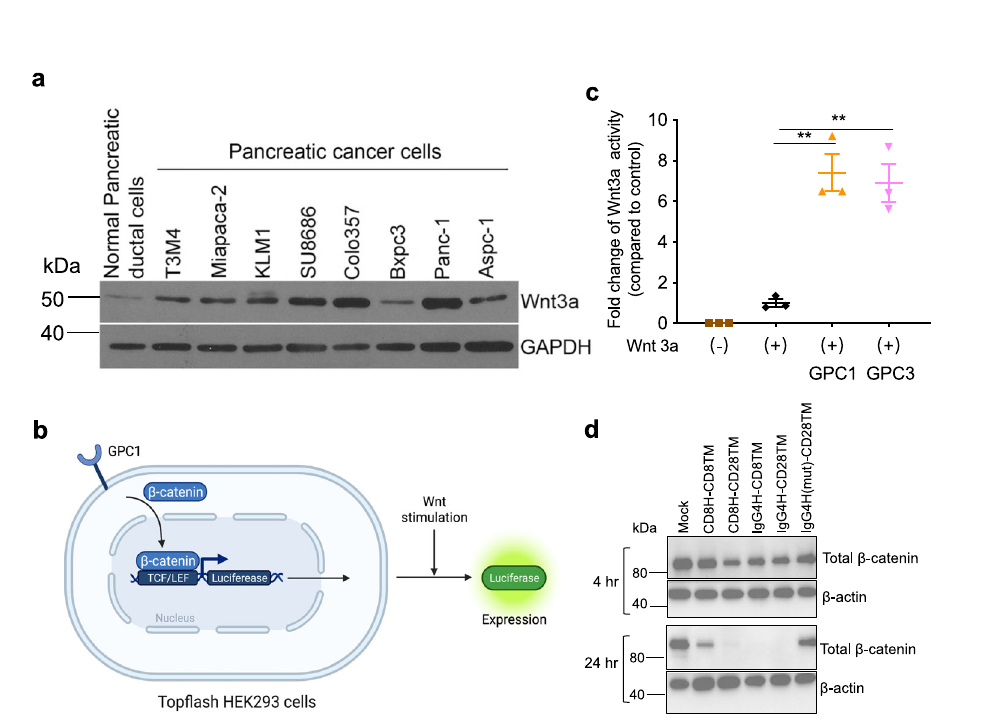
Fig. 8 | GPC1 is involved in Wnt signaling in pancreatic cancer. a Western blot analysis of Wnt3a expression in pancreatic cancer cell lines as well as the normal pancreatic ductcelllinehTERT-HPNE. b Schematicof theTCF/LEF reporterassay (created with BioRender.com). c Overexpression of GPC1 increased TCF/LEF